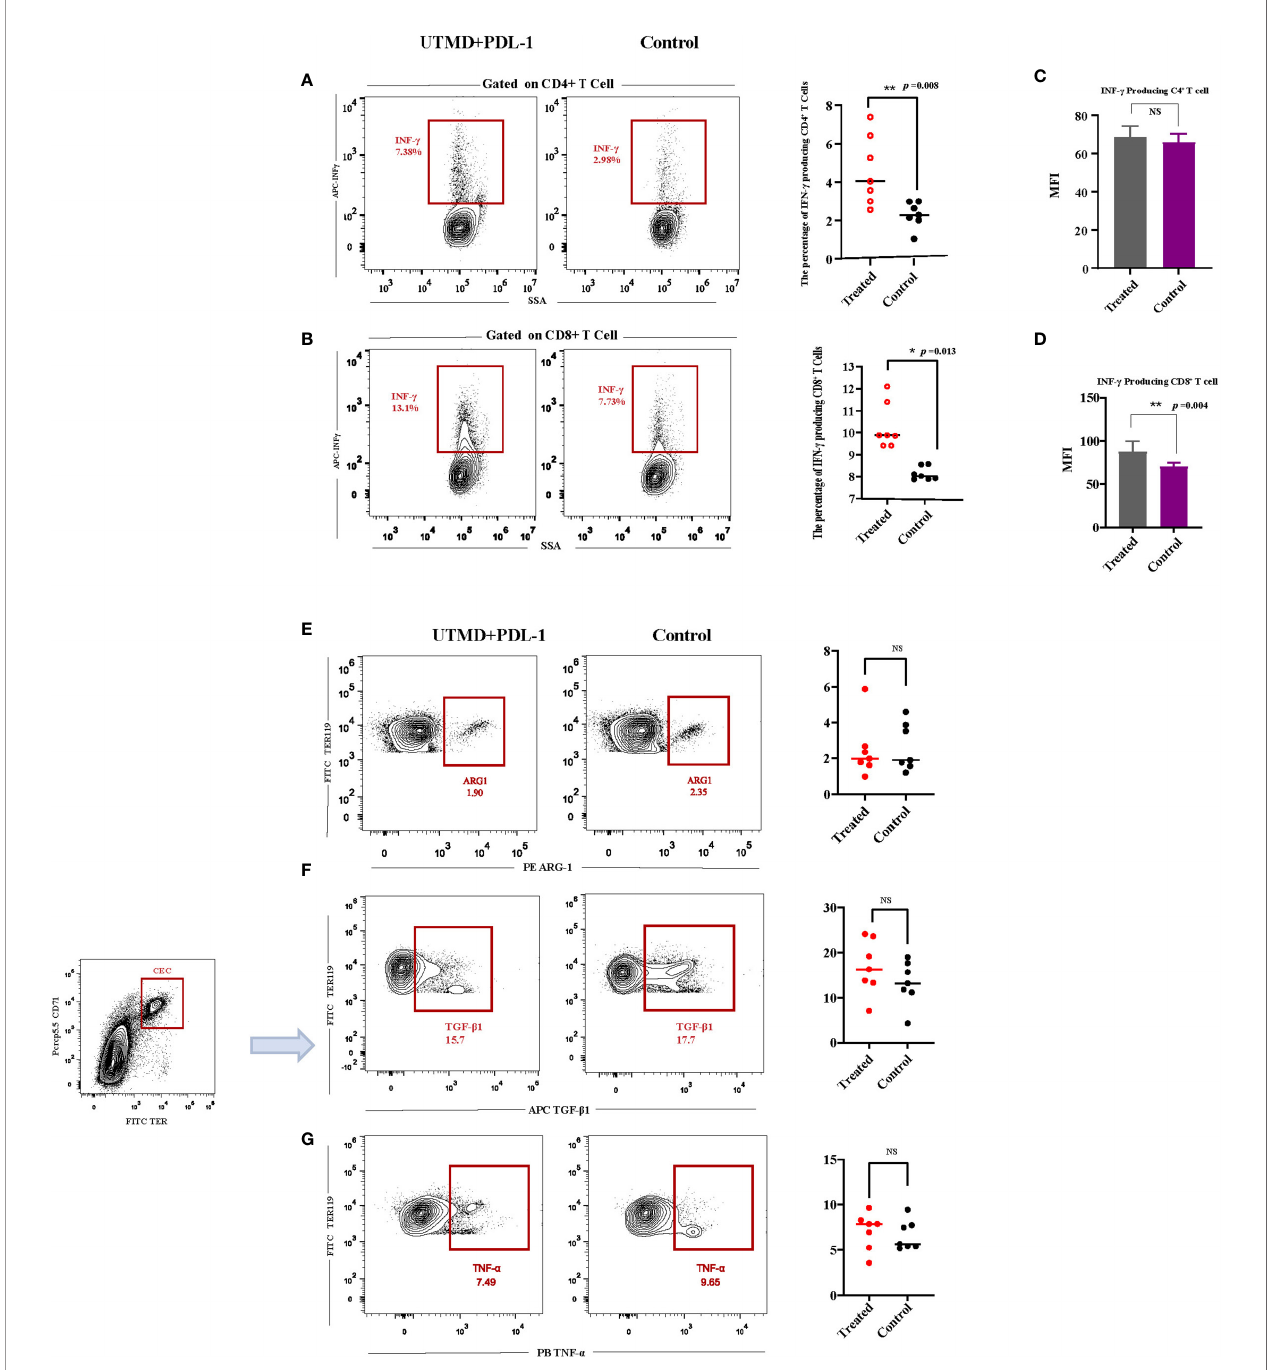
FIGURE 5 | Interferon- g (IFN- g ) and CD71 + erythroid progenitor cell (CEC) secreted cytokine productions after ultrasound-targeted microbubble destruction (UTMD) and PDL-1 combination therapy. (A, B) Representative fl ow cytometry contour plot and cumulative composite data of the frequencies of IFN- g -producing CD4 + and CD8 + T cells. (C, D) Mean fl uorescence intensity (MFI) of CD4 + and CD8 + T cells producing IFN- g . (E – G) Representative fl ow cytometry contour plot of the relative fractions of arginase-1-, TNF- a -, and TGF- b -producing CECs, analyzed by intracellular cytokine staining. Each point represents data from an individual mouse (n = 7). *P < 0.05, **P < 0.01, NS, no signi fi